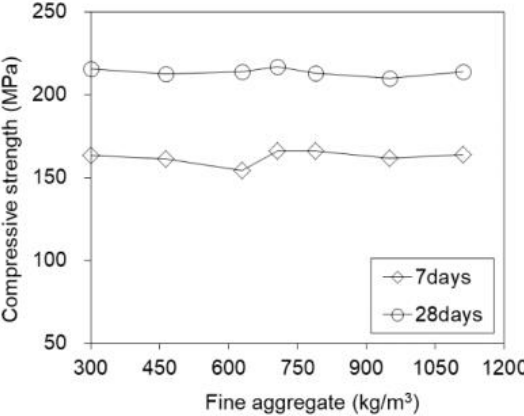
Figure 23. Compressive strength of UHPFRC with various volume of fine aggregate.